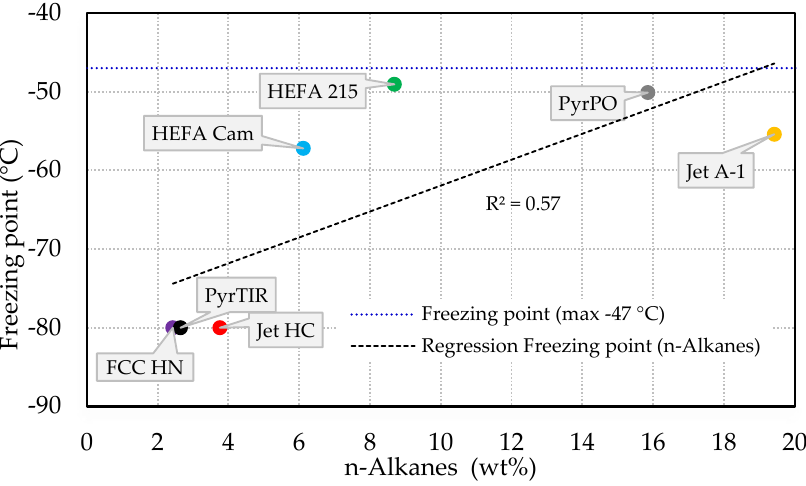
Figure 5. Freezing point relation to the n-alkanes content for the samples studied.